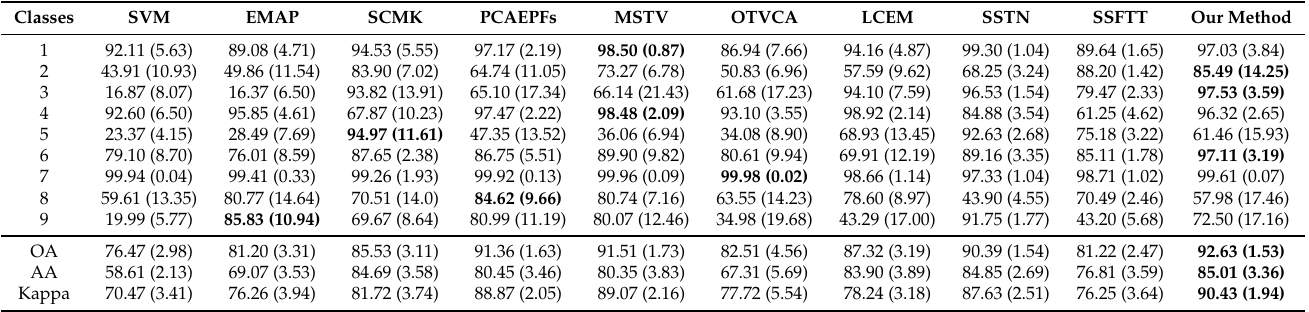
Table 2. Classification accuracies of different classification approaches on the Longkou dataset.